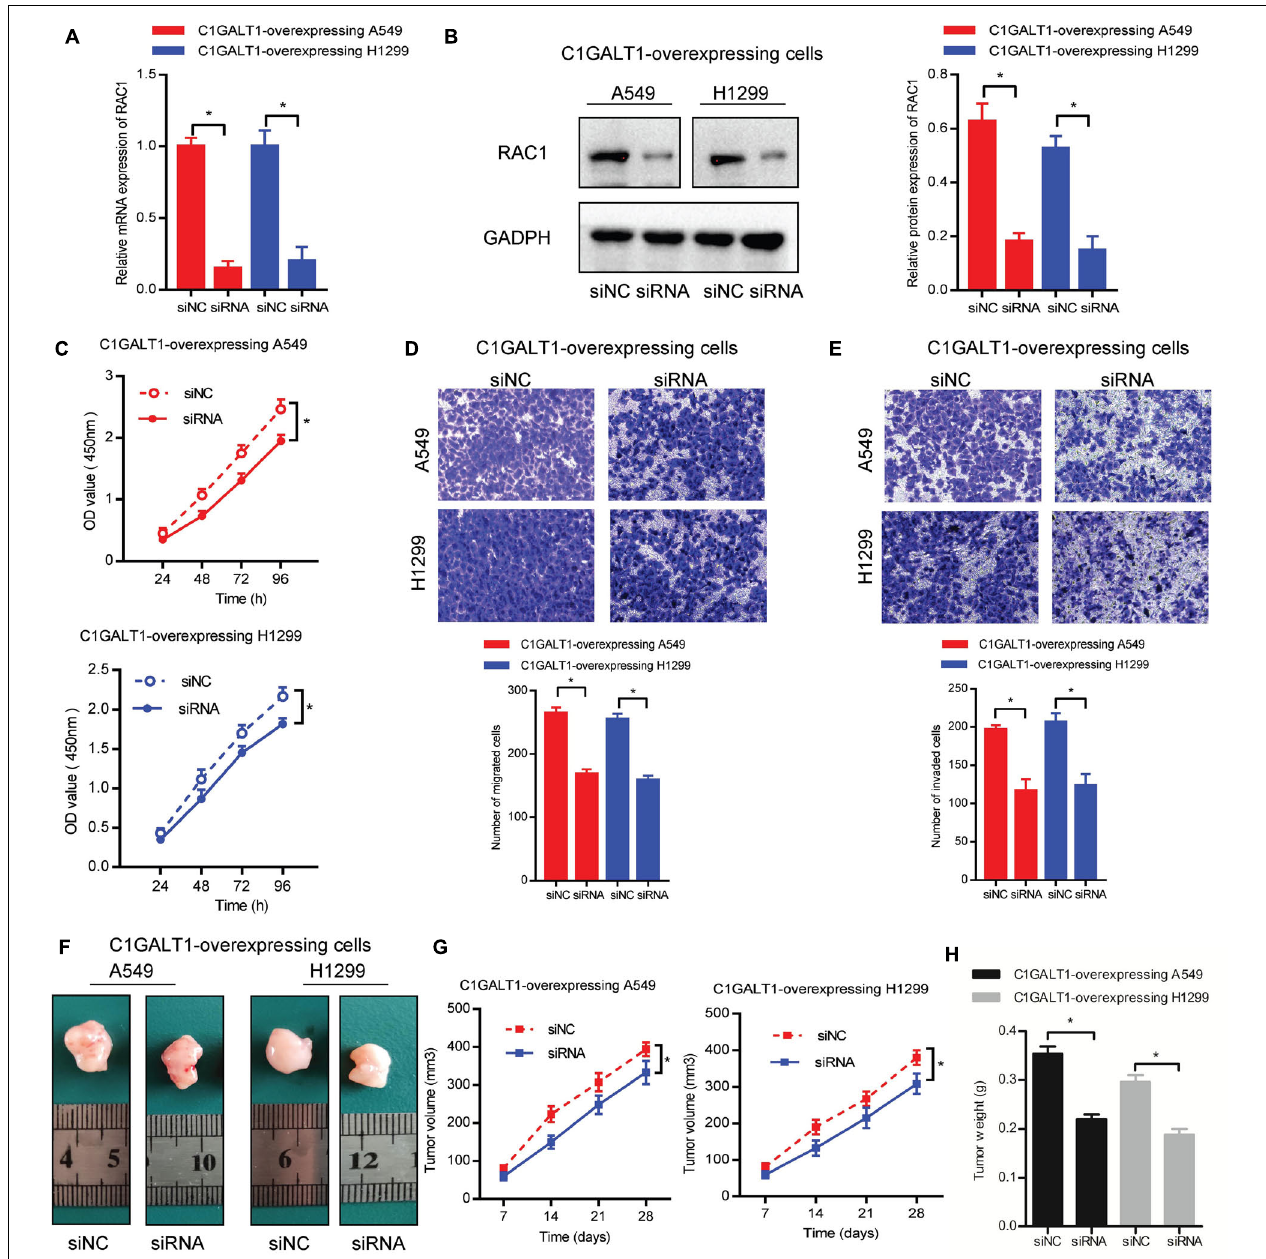
FIGURE 8 | RAC1 serves as a downstream effector of C1GALT1 in LUAD. (A,B) Analysis of RAC1 expression in C1GALT1-overexpressing cells after transfection with RAC1 siRNA by qPCR (A) and Western blot (B) . (C–E) The proliferation, migration, and invasion of cells co-transfected with C1GALT1 overexpression plasmid and RAC1 siRNA were determined by CCK-8 assay (C) , Transwell migration assay (D) , and Matrigel invasion assay (E) . (F) Representative images of excised tumors from nude mice ( n = 3 per group). (G,H) Tumor volume (G) and tumor weight (H) were measured. siNC, cells transfected with non-silencing siRNA; siRNA, cells transfected with RAC1 siRNA. Data are expressed as mean ± SD. * p <